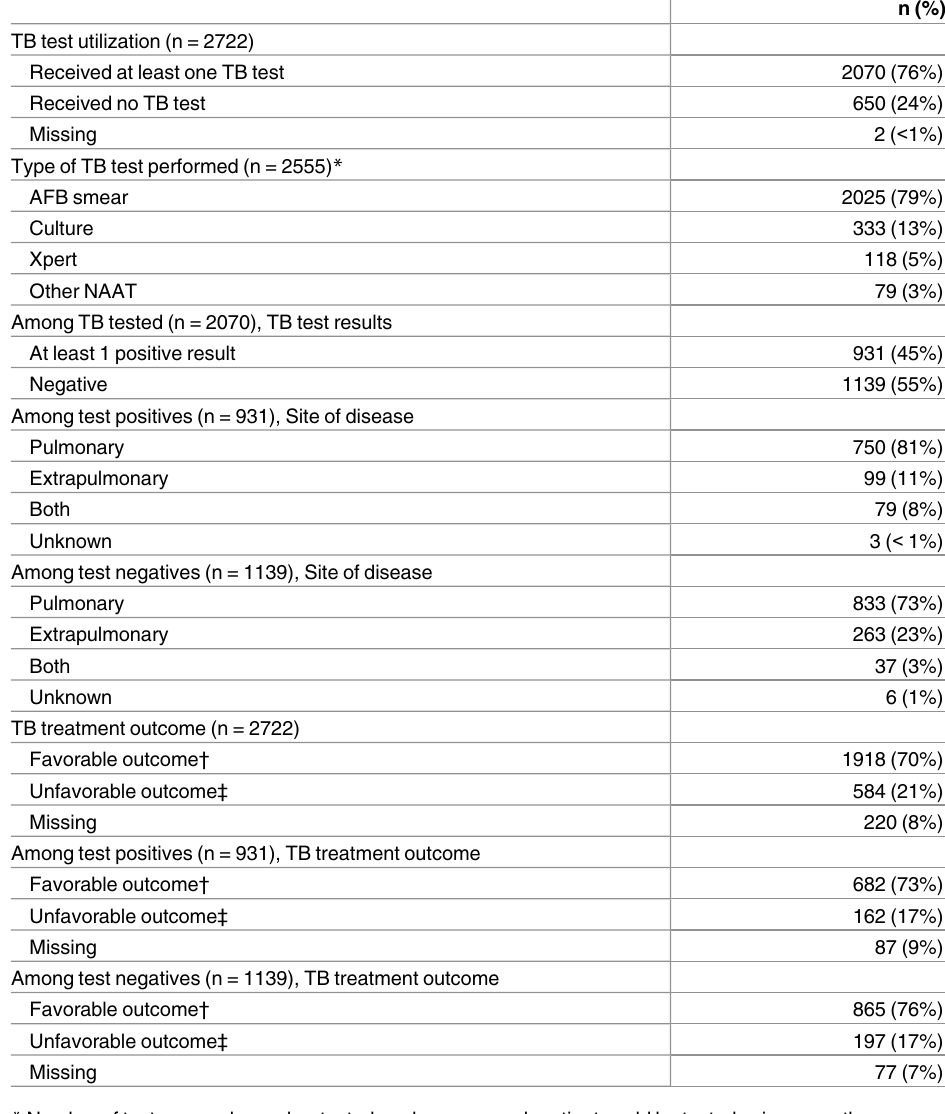
Table 3. TB testing utilization and outcomes among 2722 adult patients. TB test utilization (n =